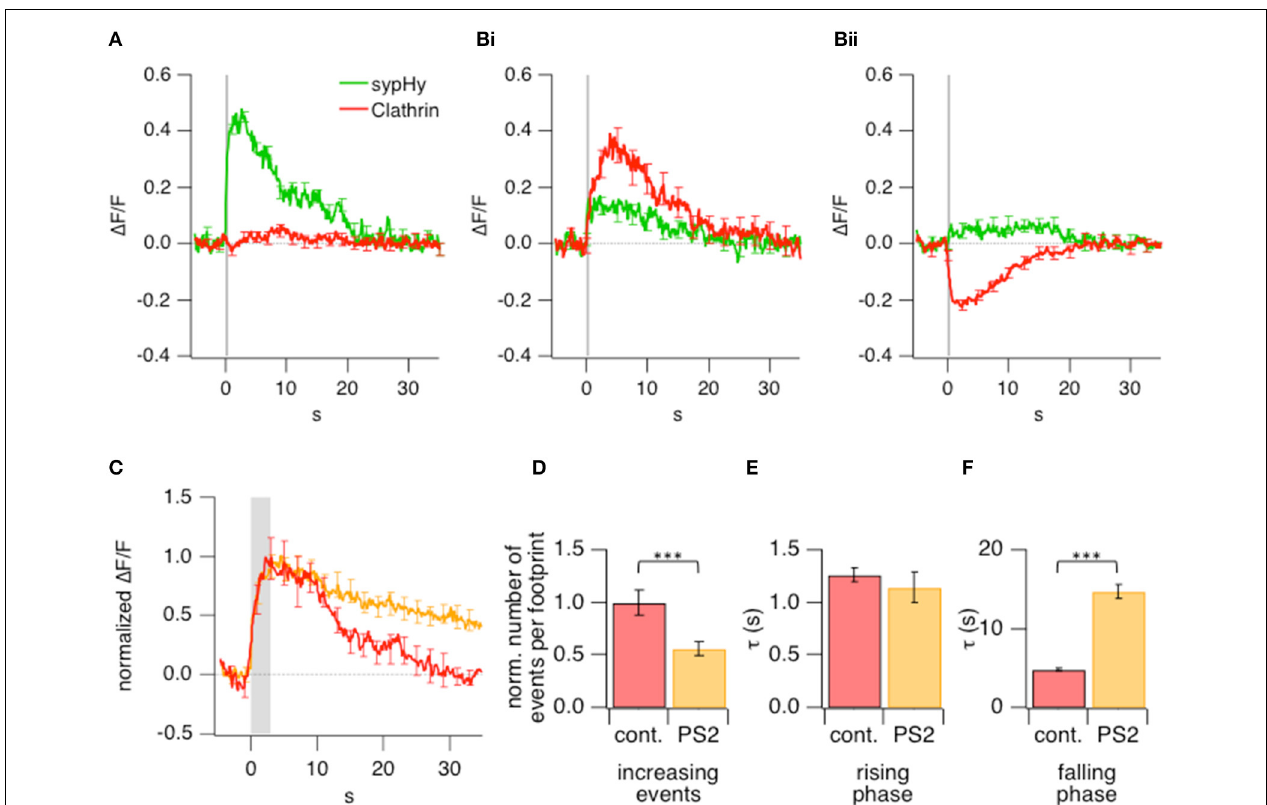
FIGURE 5 | Kinetics of exo- and endocytotic events in relation to clathrin accumulation and loss. (A) Comparison of the average sypHy signal (green) and LCa-mCherry signal (red) measured simultaneously in ROIs selected by detecting a significant increase in sypHy fluorescence during a 0.5s stimulus. 615 ROIs from 16 terminals. (B) Comparison of the average sypHy signal (green) and LCa-mCherry signal (red) measured simultaneously in ROIs selected according to a rise (i) or fall (ii) in the clathrin signal within the first 10s (cf. Figure 3C ). 438 ROIs from 16 terminals. (C) Average normalized